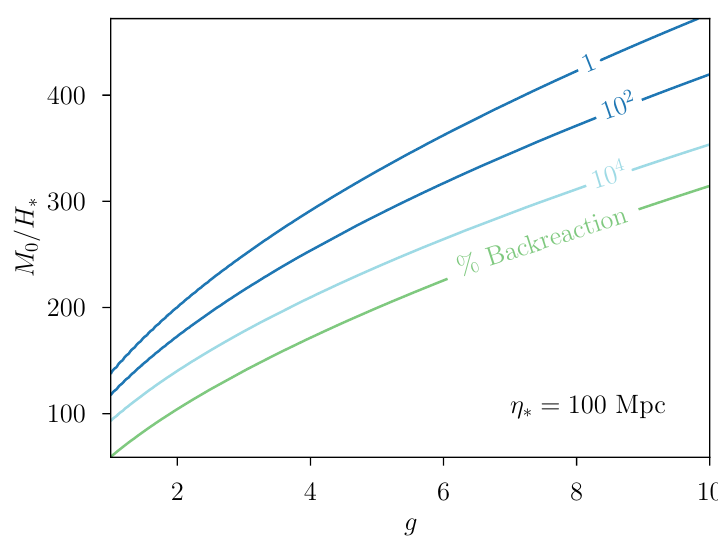
Figure 2 . Allowed parameter space for subdominant backreaction on the homogeneous inflationary dynamics for η = 100 Mpc. Below the contour labeled “% Backreaction”, the backreaction of ∗ produced particles on the slow-roll dynamics is more than a percent around a scale k ∼ 1 /η our parameter choices, we stay above this line. The other contours for different values of N (see eq. (2.23)) show that an appreciable number of hotspot can still be produced with negligible